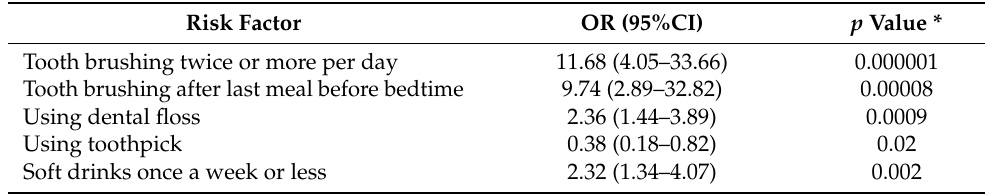
Table 4. Gender differences (Females vs. Males) in selected oral health and dietary habit behaviors of 15-year-old teenagers in Szczecin.